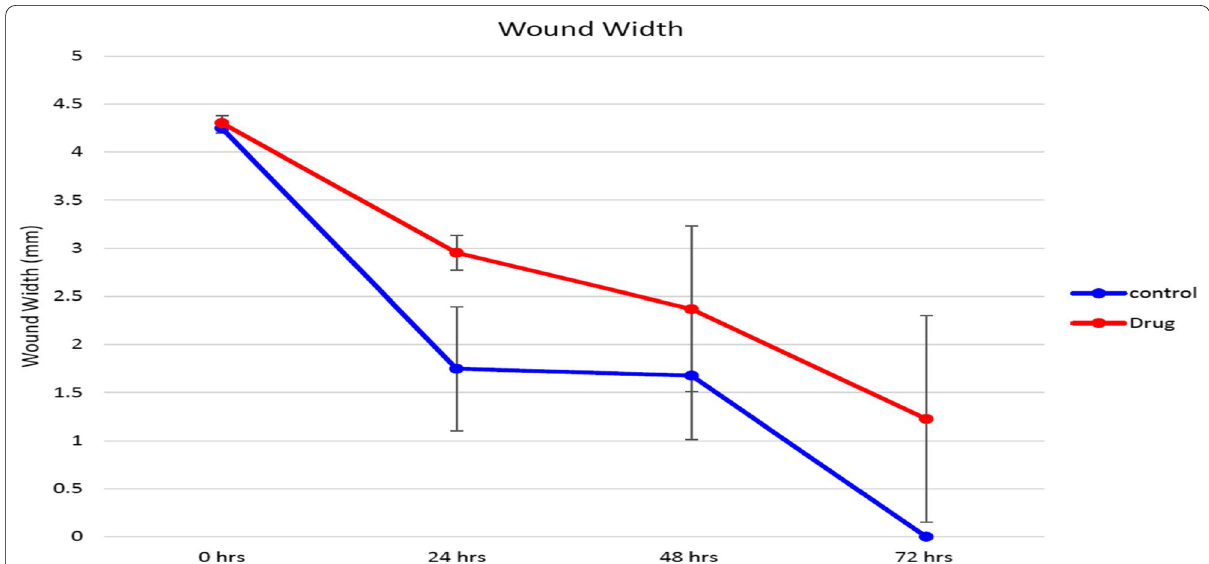
Fig. 9 Graph showing wound width at 0, 24, 48 and 72 h between control group and group of HNO97 cells treated with apricot oil extract. A clear inhibition of cell migration in the treated group is